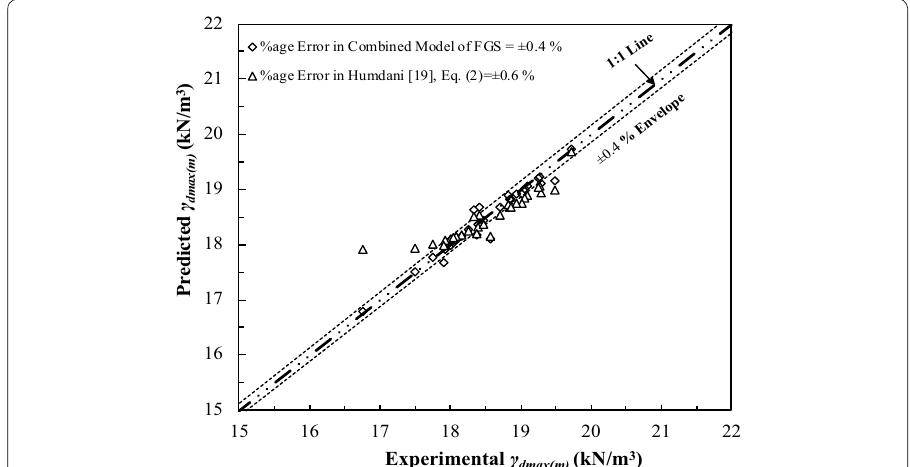
Fig. 12 Comparison of experimental versus predicted values of γ dmax(m) for combined model and Humdani [20] model based on independent data